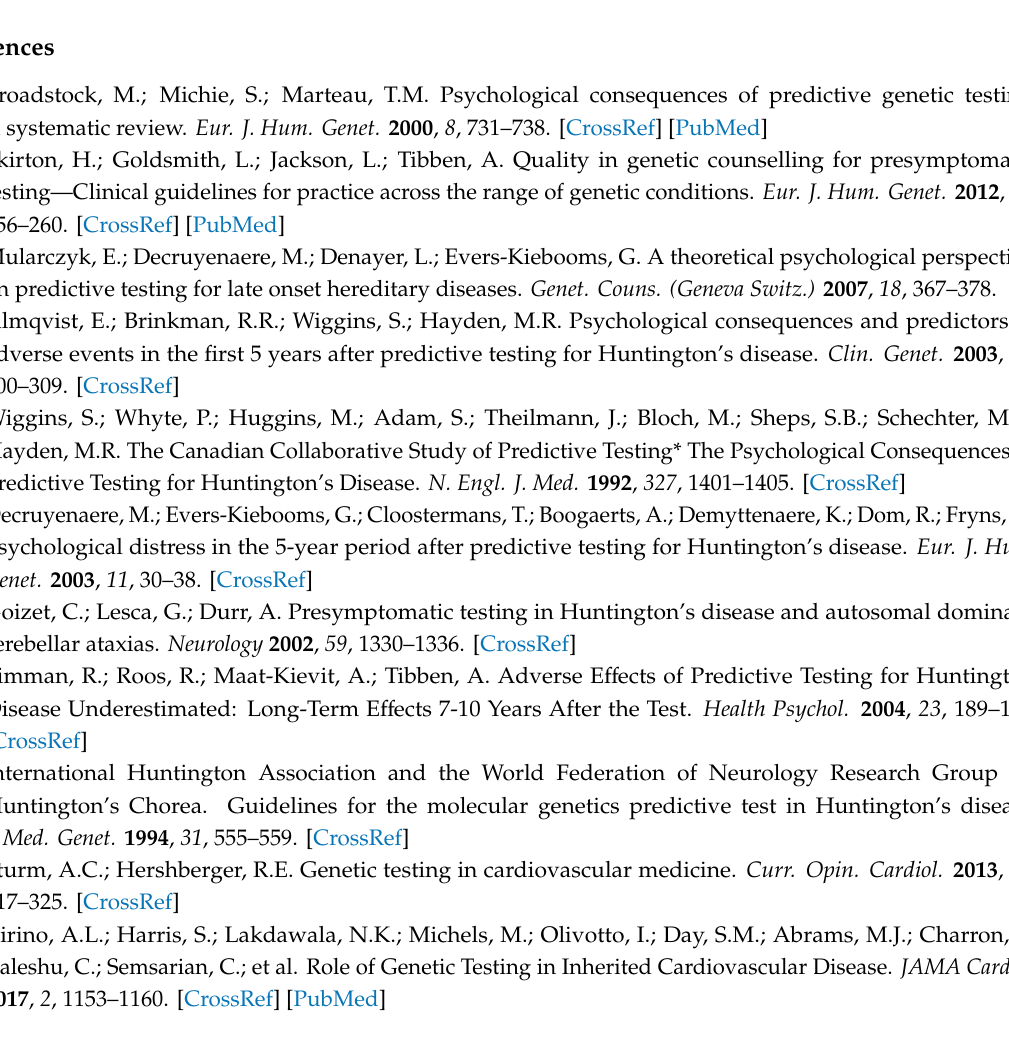
Table S1: Parameters used in univariate analysis to determine predictors of anxiety, Impact of Event Scale scores, and impact of genetic test results; Table S2: Global change after predictive genetic testing: details of changes for subjects who reported that the genetic test changed their lives; Table S3: Details of the changes in social or professional status and in family relationships for subjects who experienced change; Table S4: Descriptive analysis of STAI and distress (IES) in HCM patients versus other diseases; Table S5: Direct comparisons between mutation carriers and non-carriers; Table S6: Summary of main studies of the psychosocial impact of predictive genetic testing in hereditary heart diseases (restricted to cardiomyopathies and arrhythmias). PGT: predictive genetic testing; Figure S1: Distribution of age of subjects according to sex in the prospective cohort (A) and retrospective cohort (B); Figure S2: Social or professional changes and / or changes in family relationships in the prospective cohort (A) and retrospective cohort (B) for mutation carriers and non-carriers; Figure S3: Change in the State-Trait Anxiety Inventory state score at Qp1, Qp2 and Qp3, and the STAI state score at Qr and Figure S4: Change in the Impact of Event Scale score at Qp1, Qp2 and Qp3, and the IES score at